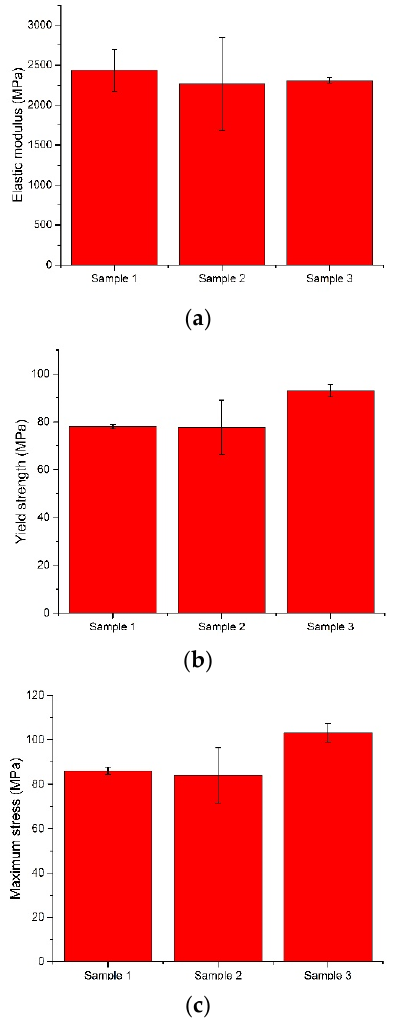
Figure 10. Comparison of the elastic modulus ( a ), the yield strength ( b ) and the maximum stress ( c ) using an ANOVA